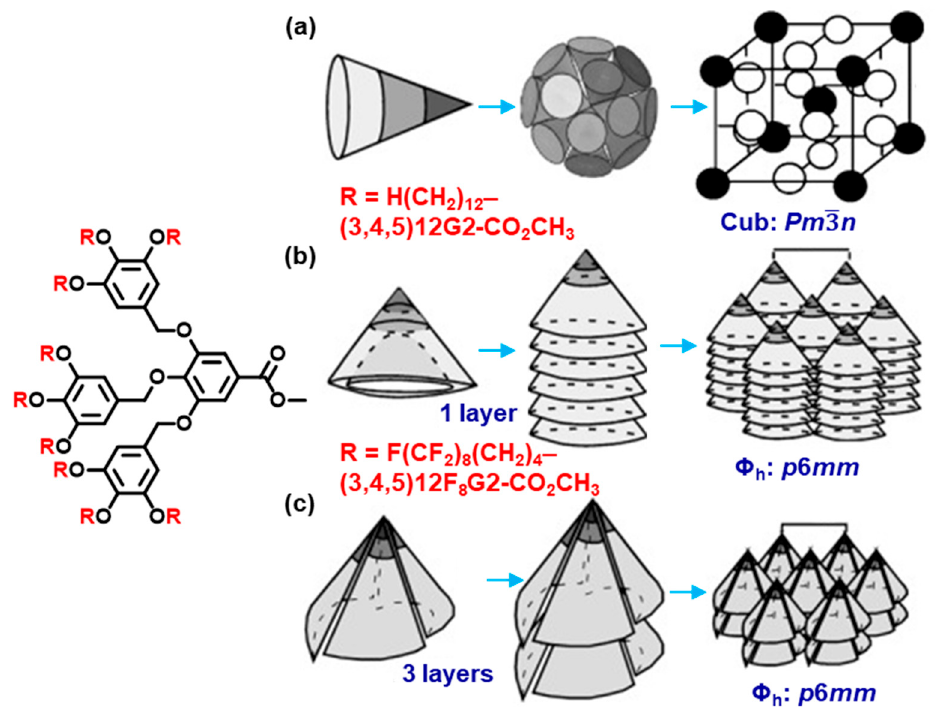
Figure 7. Chemical composition affecting the structure of self-organized supramolecular dendrimers. Structures, self-assembly, and self-organization of the second generation dendrons: ( a ) all-trans cone conformation of (3,4,5) 2 12G2-CO 2 Me; ( b ) all gauche-crown conformation of (3,4,5) 2 12F8G2-CO 2 Me; ( c ) all trans-taper conformation of (3,4,5) 2 12F8G2-CO 2 Me [136]. Parts of this Figure were adapted from [136] and modi fi ed. Copyright © 2003 WILEY-VCH Verlag GmbH & Co. KGaA, Weinheim.